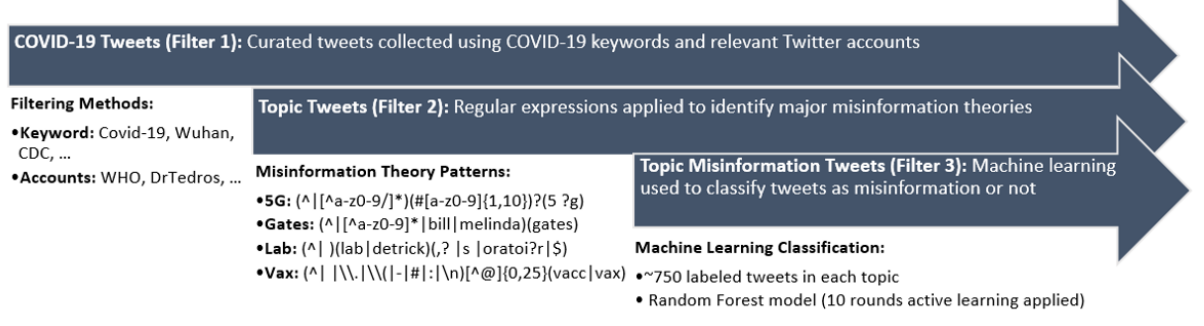
Figure 2. Tweet-filtering flow. The initial tweet corpus was obtained from Chen et al [41], who used keywords and known accounts to provide a sample of COVID-19–related Twitter data (Filter 1). We then used regular expressions to create four conspiracy theory data sets (Filter 2) and machine learning classifiers to identify misinformation tweets within each data set (Filter 3). 5G: conspiracy theories related to 5G technology; CDC: US Centers for Disease Control and Prevention; Gates: conspiracy theories related to Bill Gates or the Bill & Melinda Gates Foundation, Lab: conspiracy theories related to the virus being laboratory-released or human-made; Vax: conspiracy theories related to vaccines; WHO: World Health